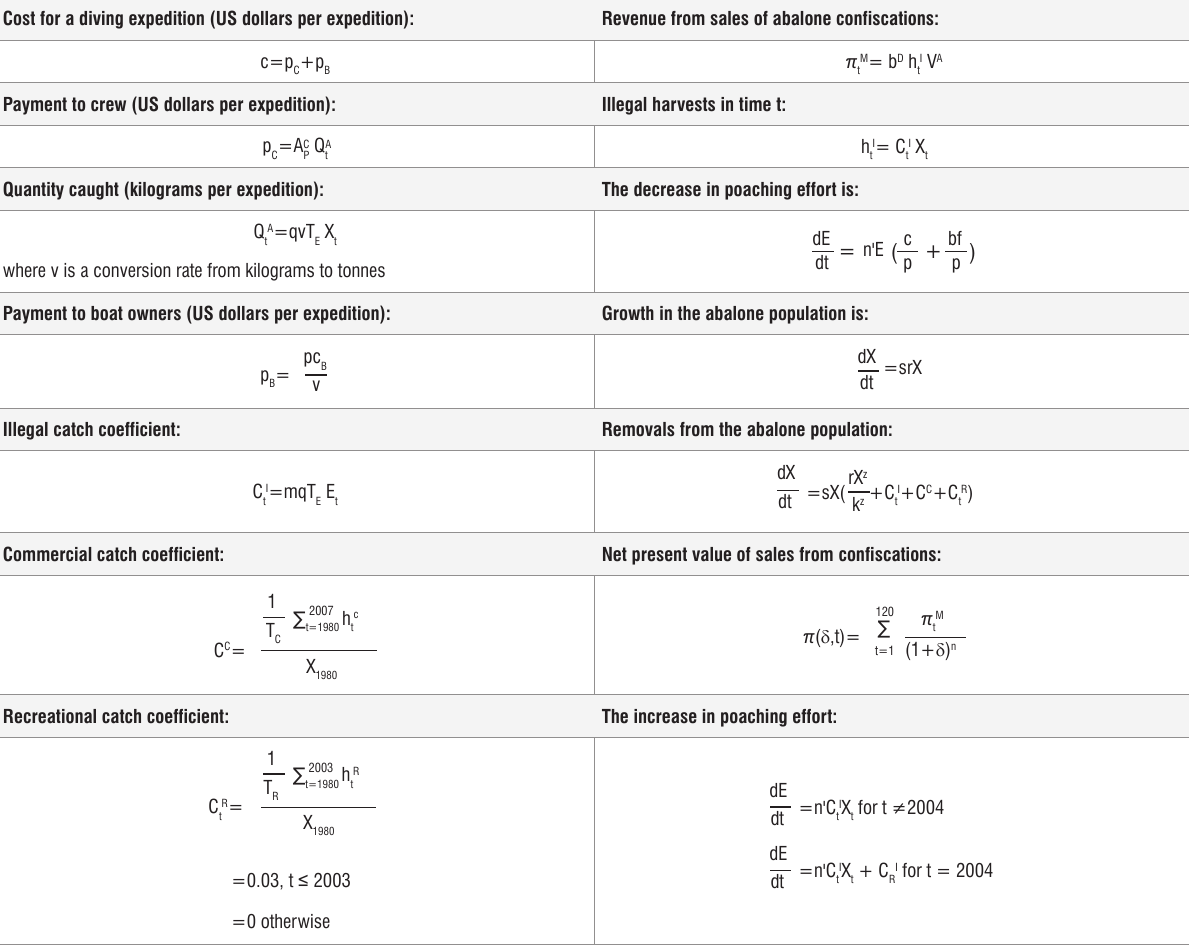
Equations for the South African abalone fishery